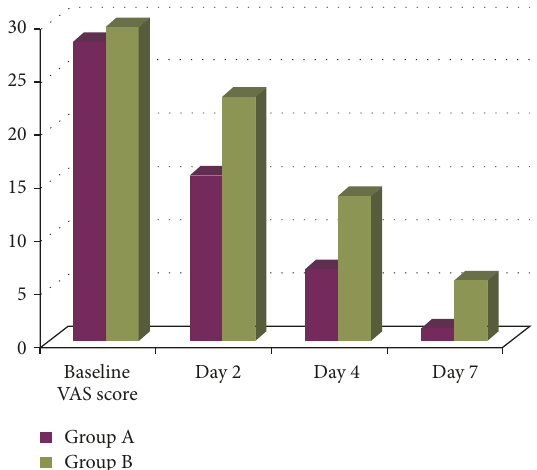
Figure 4: Intergroup comparison of ulcer areas (in mm 2